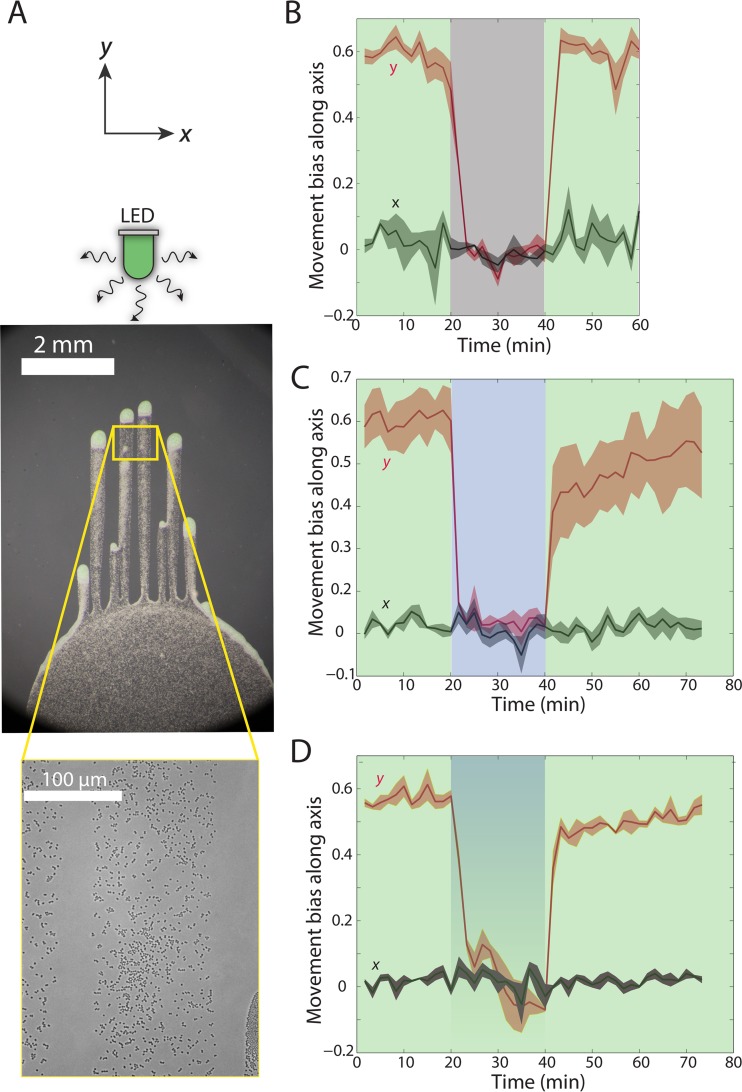
Blue light rapidly inhibits phototaxis, while recovery from inhibition occurs more slowly. Data for time zero denote results at the time of the first change in the light condition. (A) Representative phase-contrast images of the finger-like projections during times of imaging (shown in panels B to D). Cells were imaged in the mid-finger region (highlighted by the yellow box). (B) Cells were imaged for 20 min with incident green light (1.03 µE m−2 s−1 at 535 nm), after which time the light source was switched off for 20 min and then switched back on for 20 min. The motility bias parallel to the light quickly dropped to near zero once the light was turned off and then reestablished its original value within 100 s of light restoration. At least 150 cells were used for each measurement. Error bars represent the standard errors of the means for 4 independent droplets. (C) Cells were imaged for 20 min with incident green light, after which the green LED was switched off for 20 min and a blue LED (1.9 µE m−2 s−1 measured at 435 nm) was turned on, and then the two were switched back on and off, respectively, for 20 min. (i) Motility bias parallel to the light quickly dropped to near zero upon the first switch (green LED off). However, bias only recovered partially upon the second switch (green LED on) and then slowly approached the initial value over tens of minutes. At least 500 cells were used for each measurement with green light, and at least 150 cells were used for each measurement with blue light. Error bars show the standard error of the mean from 3 independent droplets. (D) As for panel C, except that the green LED was kept on throughout the experiment. (i) The decrease in motility bias upon blue LED illumination occurred more slowly than in panels B and C (over a few min). This bias recovered to a value much closer to the original value than the data shown in panel C, indicating that the inhibitory effect of blue light was ameliorated. At least 500 cells were used for each measurement with green light, and at least 150 cells were used for each measurement with blue and green light. Error bars indicate the standard error of the mean for 3 independent droplets.